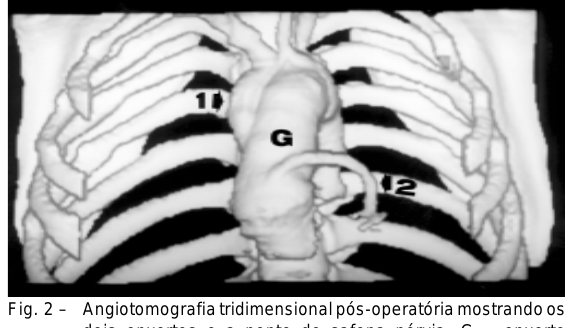
Fig. 2 – Angiotomografia tridimensional pós-operatória mostrando os dois enxertos e a ponte de safena pérvia. G = enxerto corrugado de pericárdio bovino (PB); flecha 1 = enxerto sintético entre tronco braquiocefálico e o enxerto de PB; flecha 2 = veia safena para artéria descendente anterior.